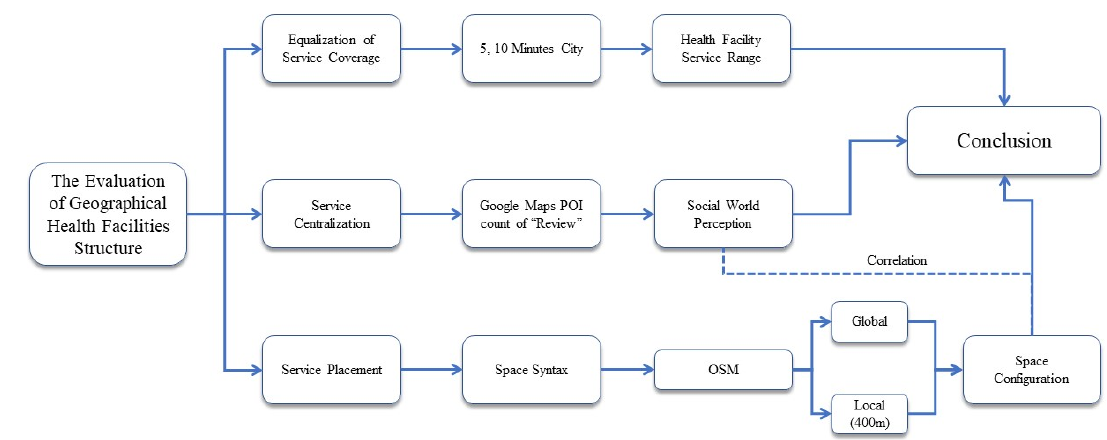
Figure 1. Research Flowchart.